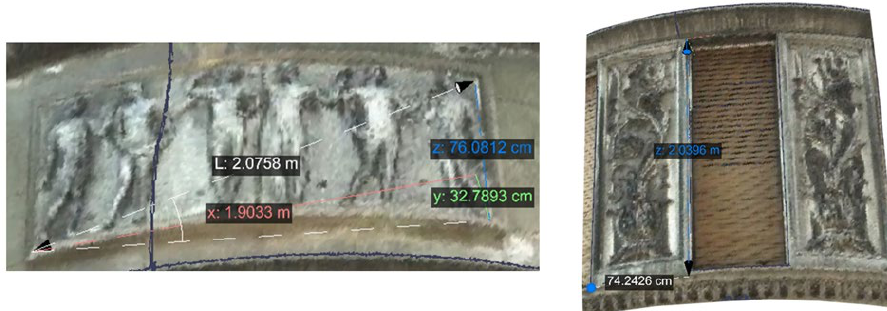
Figure 8. Carrying out determinations on architectural elements within the digital models of the Heyman House through the “measurements” option from the Cintoo platform.